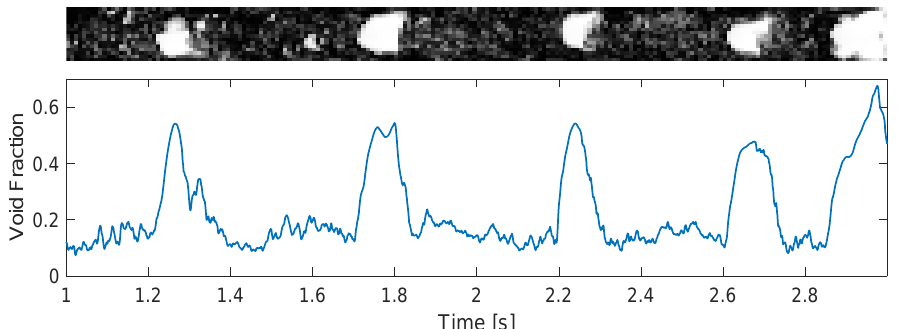
Figure 13. Gas–liquid distribution ( top ) and volumetric fraction of air ( bottom ) of a slug flow measured by the wire-mesh sensor installed upstream of the ISS for a water flow rate of 80 L/min and an air flow rate of 70 Ln/min. The two images correspond to the same data and share the same time axis. Gas is represented in white and liquid in black in the images, with the light intensity of gray pixels proportional to the local gas fraction measured by the WMS.